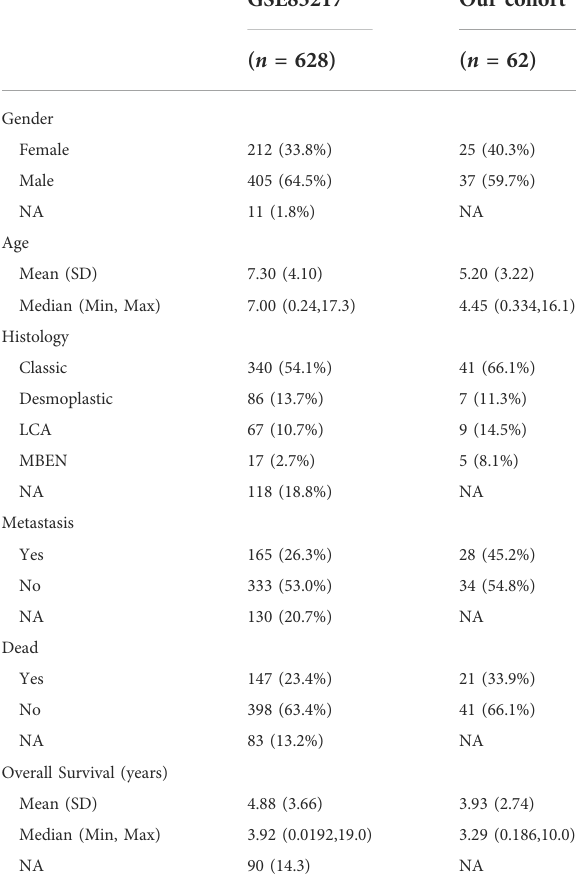
TABLE 1 Data of RNA-seq included for Kaplan-Meier